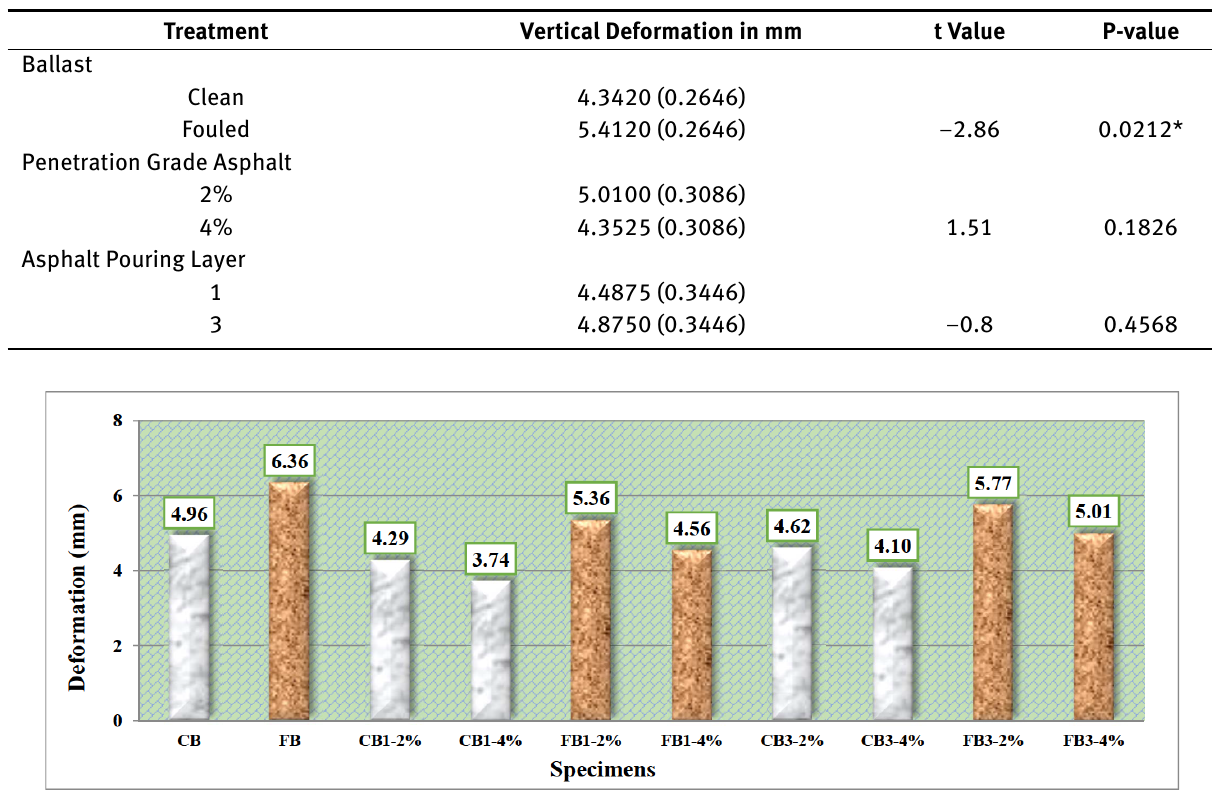
Figure 3: Vertical deformation rate after the first loading